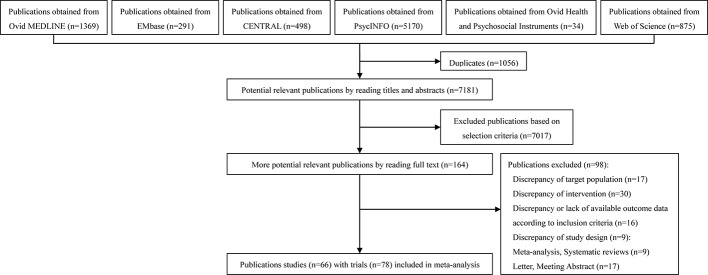
Study selection.